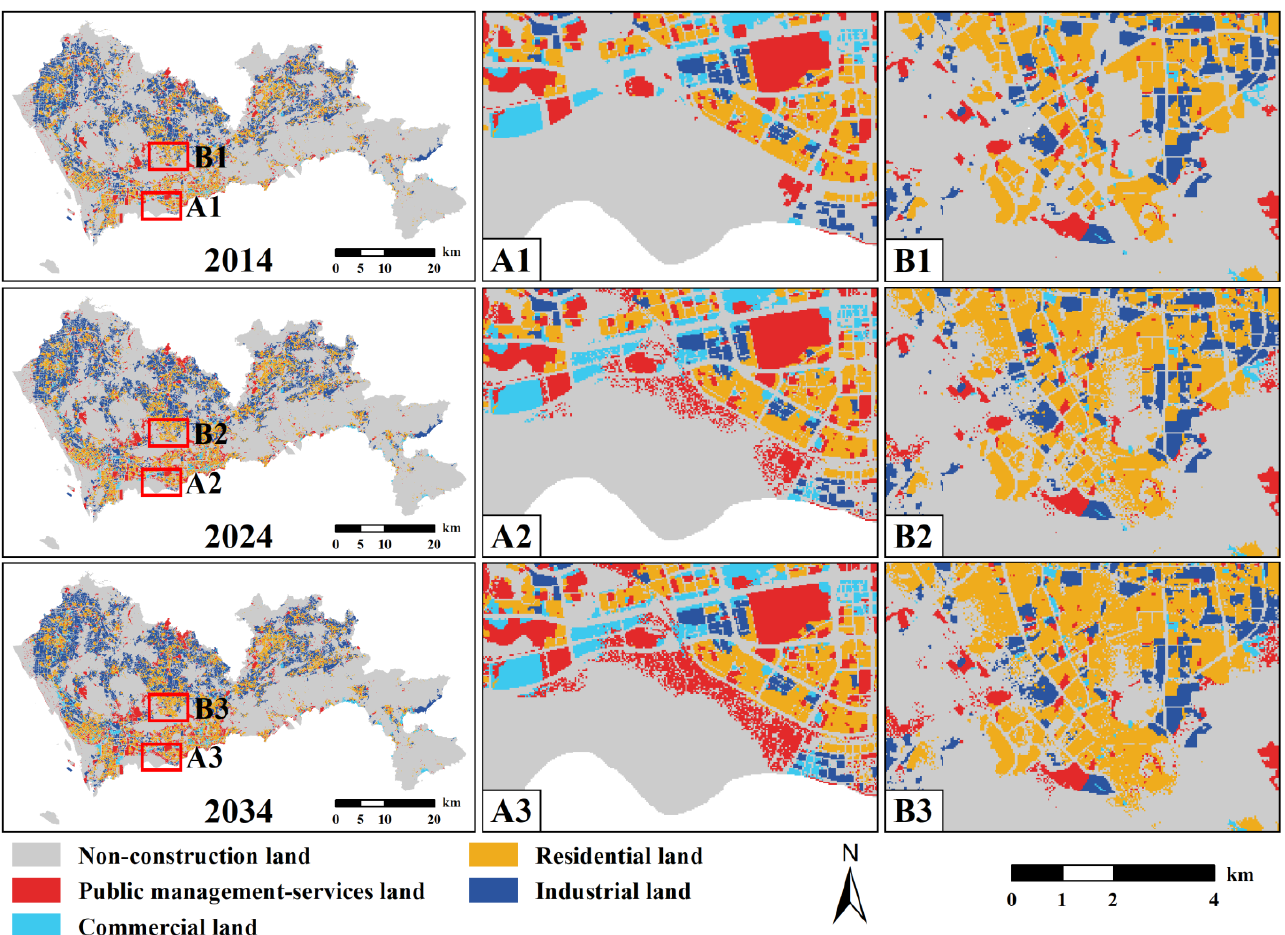
Figure 11. Simulated urban land use patterns of Shenzhen in the horizontal direction, 2014 – 2034. ( A ) The region near Shenzhen Bay; ( B ) The region near the Shenzhen North Railway Station in the south of Longhua District; ( A1 – A3 ) represent the urban land use patterns of region A in 2014, 2024 and 2034; ( B1 – B3 ) represent the urban land use patterns of region B in 2014, 2024 and 2034.